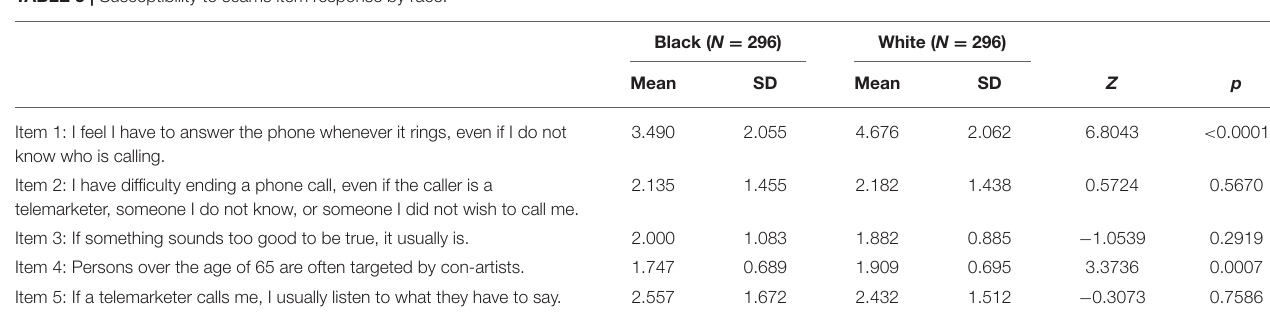
TABLE 3 | Susceptibility to scams item response by